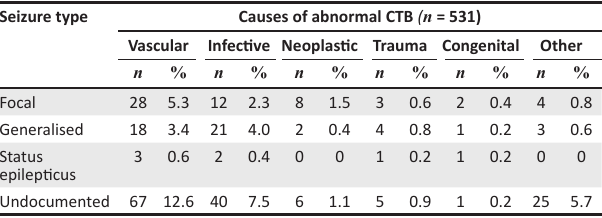
TABLE 4 : Relationship between seizure type and abnormal CTB categories. Seizure type Causes of abnormal CTB ( n = 531) Vascular Infective Neoplastic Trauma Co ngenital